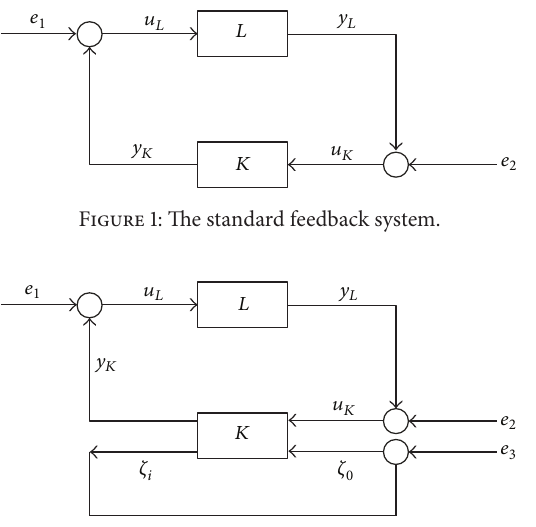
Figure 2: The plant 𝐿 connected to a controller 𝐾 with internal